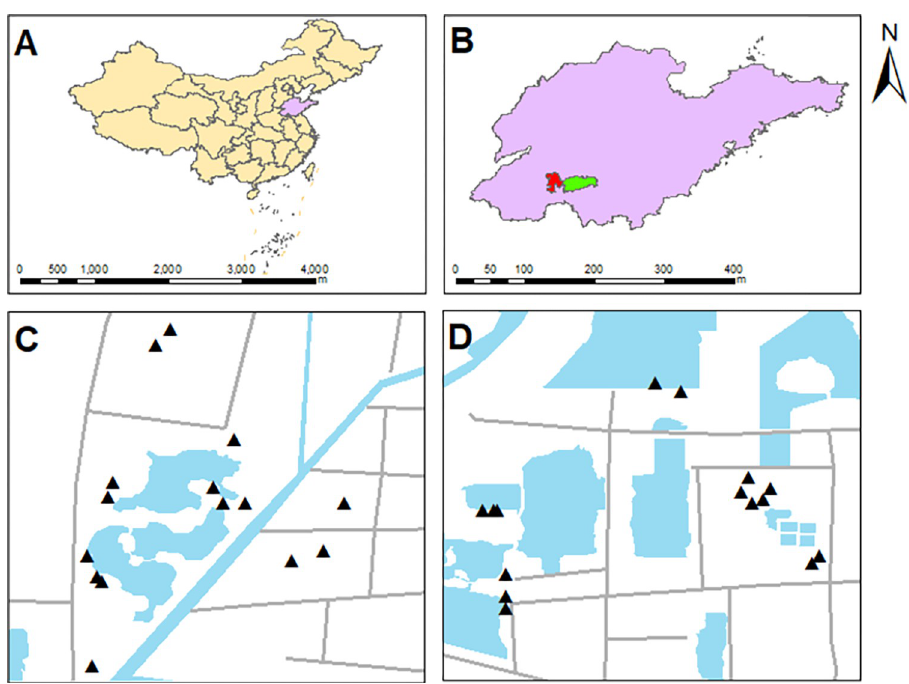
Fig 1. Research area and sample sites. Maps of Shandong Province in China ( A ) and parts of Jining City in Shandong Province ( B ) were approved by the Ministry of Natural Resources of China and the approval numbers are GS (2020) No.4630. C and D are maps of the sample sites, made by ArcMap